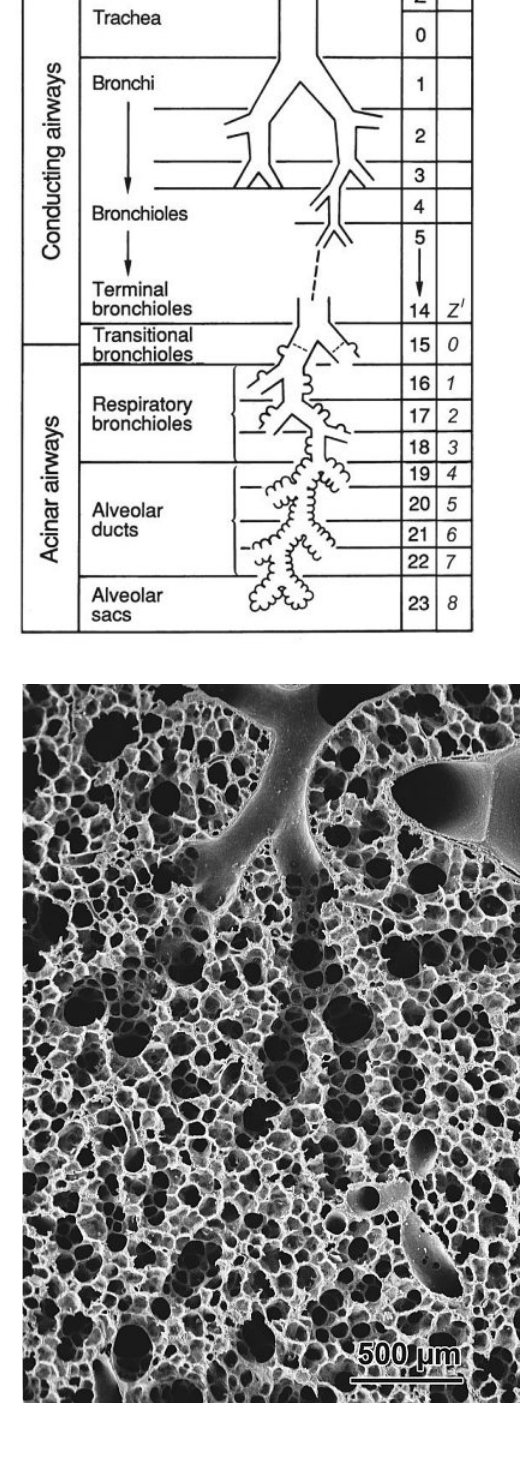
Model of airway branching in human lung by regularised dichotomy from tra- chea (generation z = 0) to alveolar ducts and sacs (generations 20 to 23).The first 14 generations are purely conducting; transitional airways (generation 15) lead into the acinar air- ways with alveoli branching over eight generations (z’).